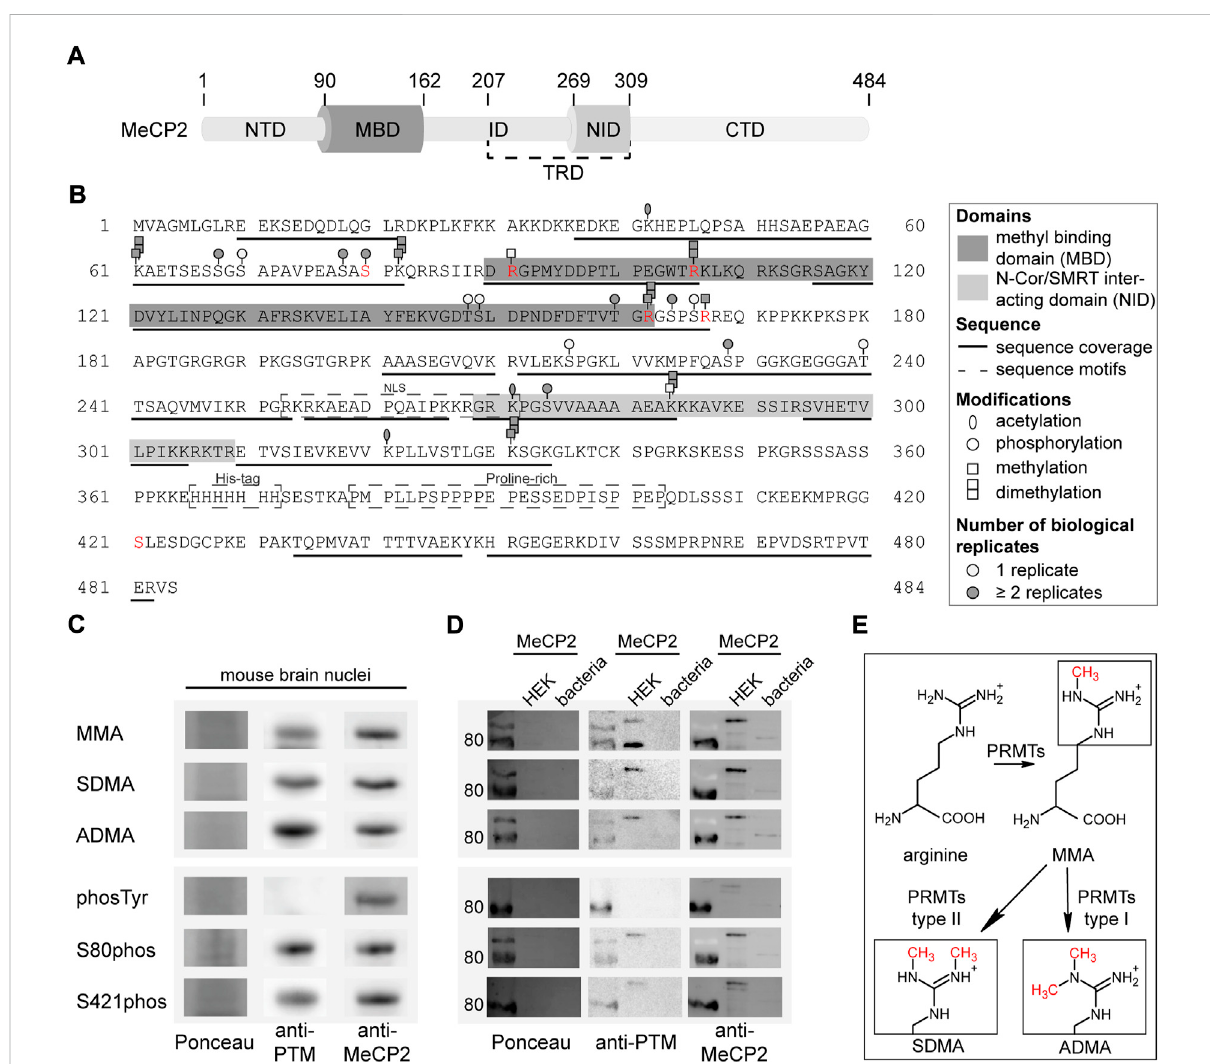
FIGURE 1 Post-translationalmodi fi cationsofMeCP2frommousebrainidenti fi edbymassspectrometryanalysis. (A) MeCP2domainstructurecomprising N-terminal domain (NTD), methyl-CpG binding domain (MBD), intervening domain (ID), N-CoR/SMRT interacting domain (NID), transcriptional repression domain (TRD) and C-terminal domain (CTD). (B) MeCP2 protein sequence with modi fi cations identi fi ed by mass spectrometry. MBD and NID, sequence coverage, sequence motifs, PTMs (acetylation, phosphorylation, methylation, dimethylation) and the number of biological replicates from independent experiments are marked as indicated. Modi fi cations selected for further validation are marked in red. The software- based annotation of spectra and modi fi cation sites shown were obtained from Proteome Discoverer and MaxQuant. The arginine methylation sites selected for further validation were additionally manually inspected (see Supplementary Figures S4 – 6). The location of modi fi cations identi fi ed on the same peptide might be uncertain. (C) Western blot analysis of mouse brain nuclei extracts tested for monomethyl arginine (MMA), symmetric dimethyl arginine (SDMA), asymmetric dimethyl arginine (ADMA), tyrosine phosphorylation (phosTyr), S80 and S421 phosphorylation (phos) and reprobed with MeCP2 speci fi c antibodies. The full membranes of the Western blots are shown in Supplementary Figure S7. (D) Western blot analysis of MeCP2-GFP puri fi ed from human HEK cells and MeCP2 puri fi ed from E. coli probed with the same modi fi cation speci fi c antibodies and reprobed with MeCP2 speci fi c antibodies. The Ponceau stain visualizes the total proteins on the membrane and the full membranes are shown in Supplementary Figure S7. (E) Scheme of the arginine methylation reaction: protein arginine methyltransferases (PRMTs) can catalyze the monomethylation of arginine and subsequently the dimethylation, which can occur either on the same nitrogen (ADMA, catalyzed by type I PRMTs) or on the unmodi fi ed nitrogen (SDMA, catalyzed by type II